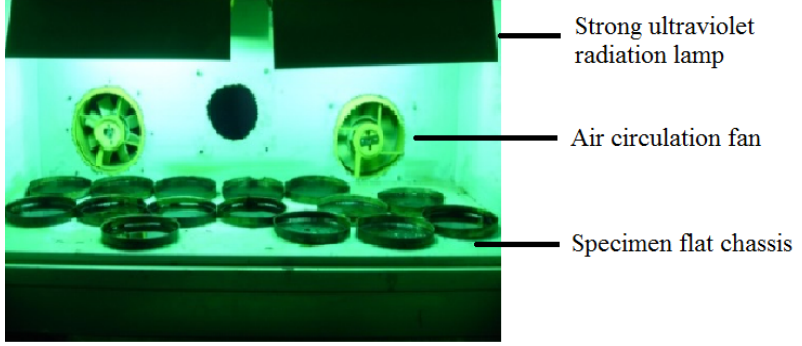
( b ) Figure 8. The comparison of average penetration depth. ( a ) 0.5 kg/m 2 ; ( b ) 1 kg/m 2 . In 0.5 kg/m 2 , the surface groove of the specimen was fully filled, a bubble came out from a larger gap that the agent was quickly penetrating and the average penetration depth in 5–7% porosity was over 10 mm after 2 h. It kept growing and reached 15–20 mm after 24 h. In 1 kg/m 2 , the average penetration depth reached 10 mm after 2 h, and 15–30 mm after 24 h. We can see that both dosages can completely penetrate the aged asphalt layer. The permeation depth in 2 h and 8 h accounted for about 50% and 75% of the whole 24 h results. The first 2 h was the main infiltration period. By chosing 1 kg/m 2 a faster and deeper penetration effect can be obtained, but it requires higher maintenance costs. In summary, the pavement should be closed at least 2 h after spraying the LS pre ‐ maintenance agent, a conditional section can be extended to 8 h and above. 0.5 kg/m 2 can ensures sufficient penetration depth and effect while controlling the cost. 5.2. Restore Performance The results of the matrix asphalt with adding 25, 35, and 45% asphalt mass of LS pre ‐ maintenance agent and Rhinophalt are shown in Table 7.